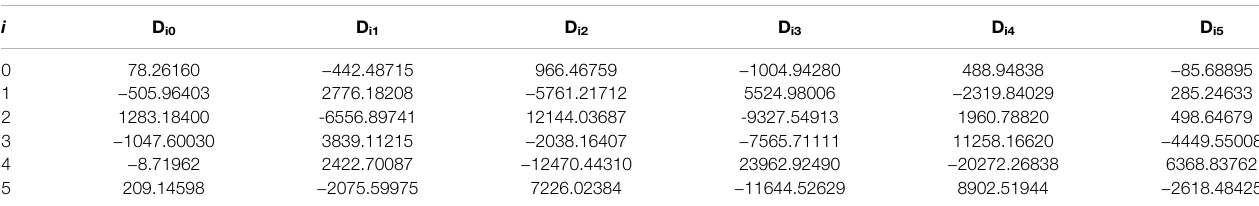
TABLE 9 | Coef fi cients D ij of c p ( h , p ) .